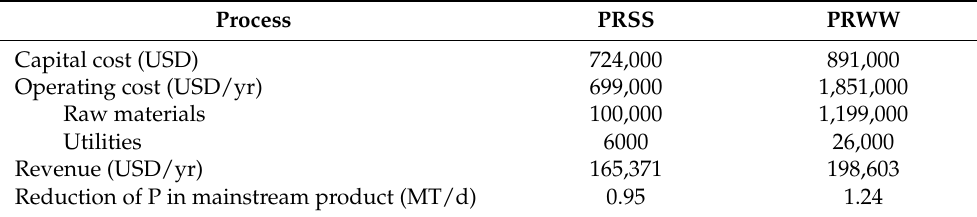
Table 3. Changes in process economics with the addition of the P recovery